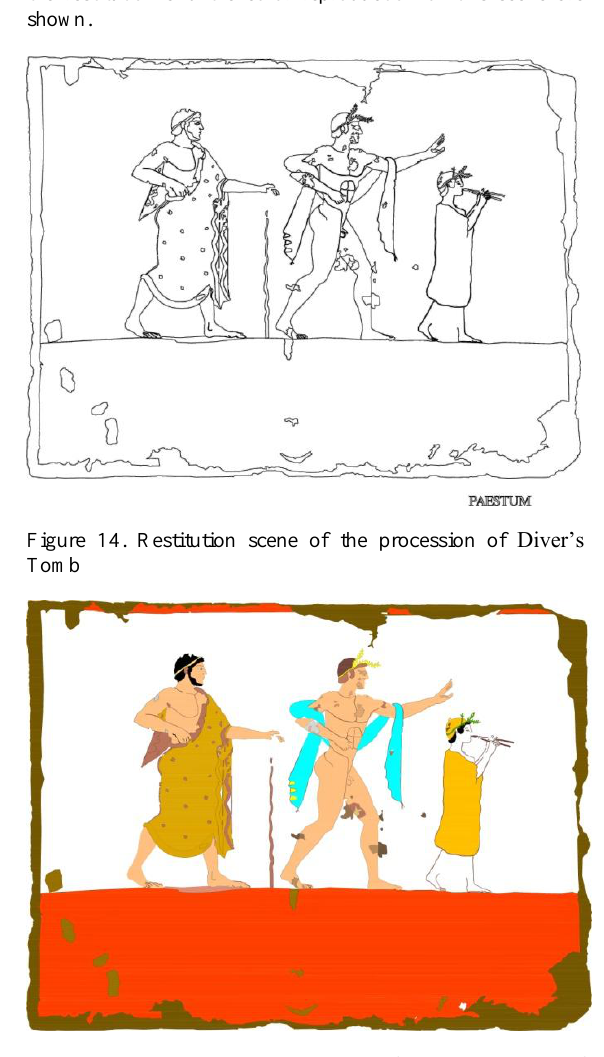
Figure 15. Color restitution scene of the procession of Diver’s